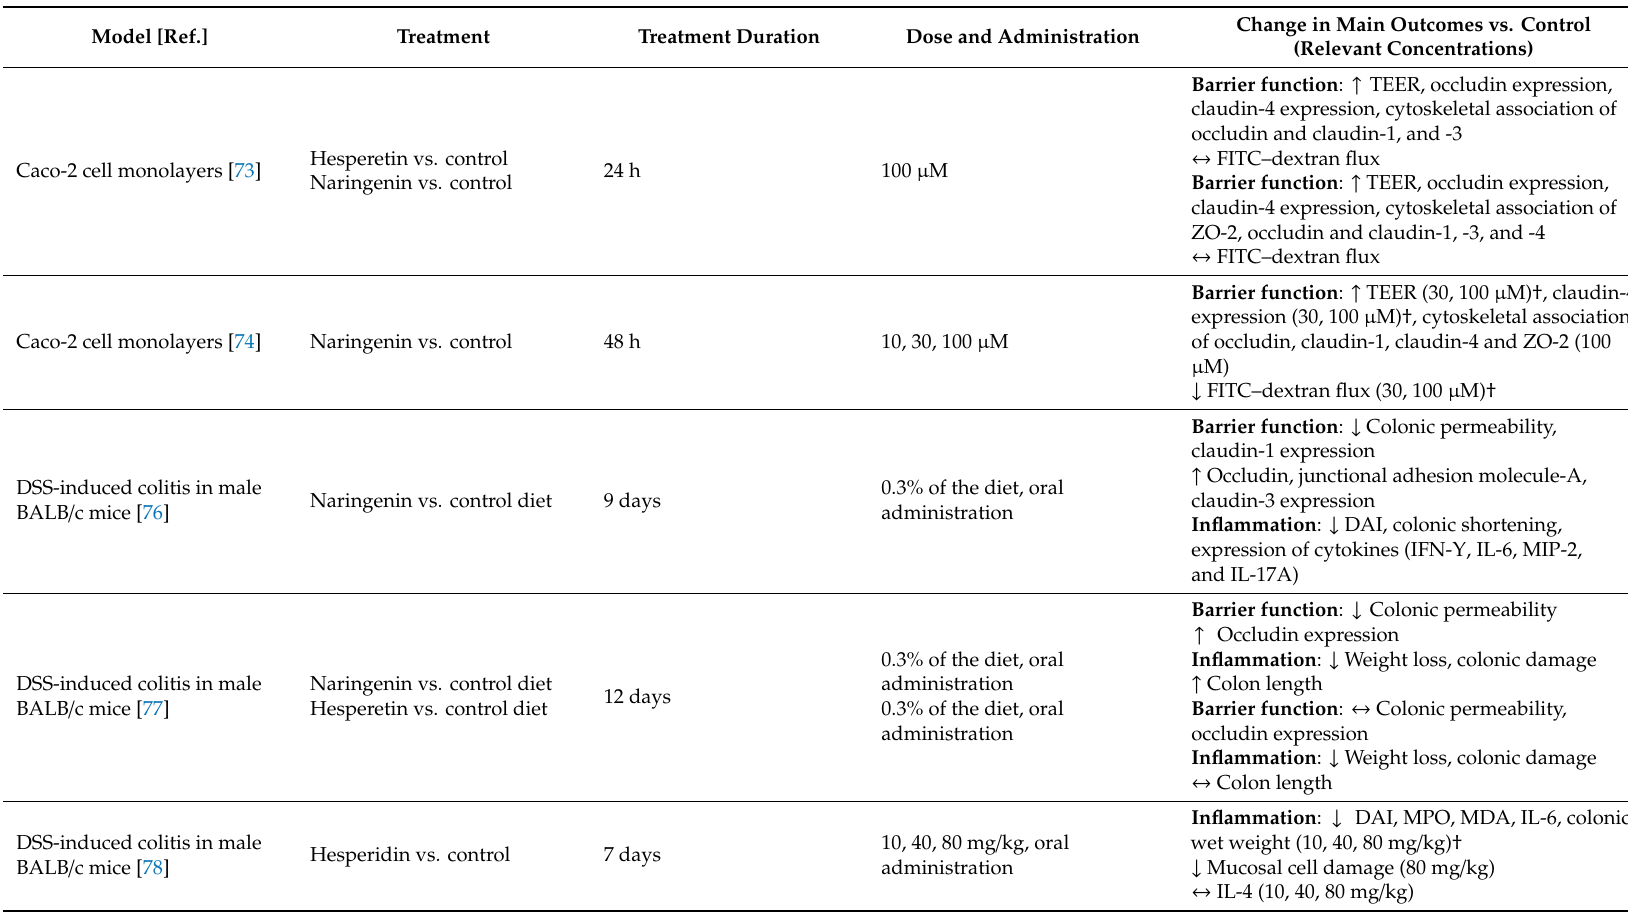
Table 3. Nonexclusive listing of studies on the e ff ects of citrus flavanones on host parameters related to barrier function and inflammation. Model